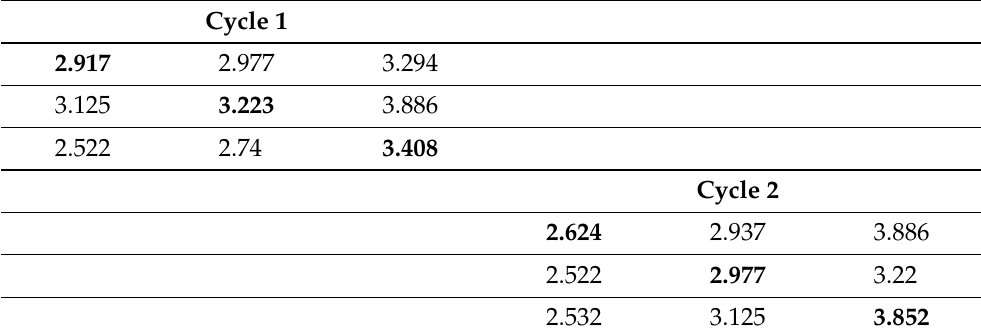
Table 13. RSS scheme from the GB( θ , λ ) distribution when c = 2 and n = 6.